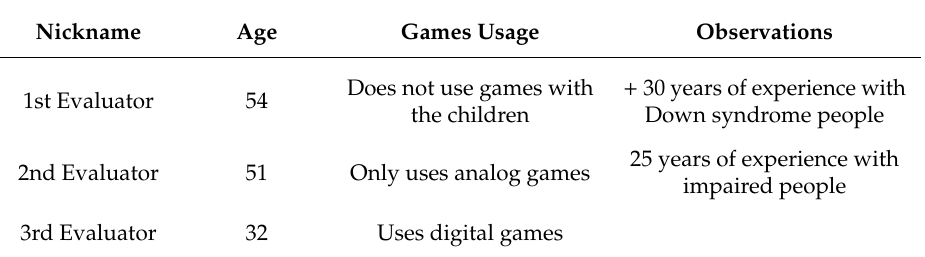
Table 11. Health professionals profile